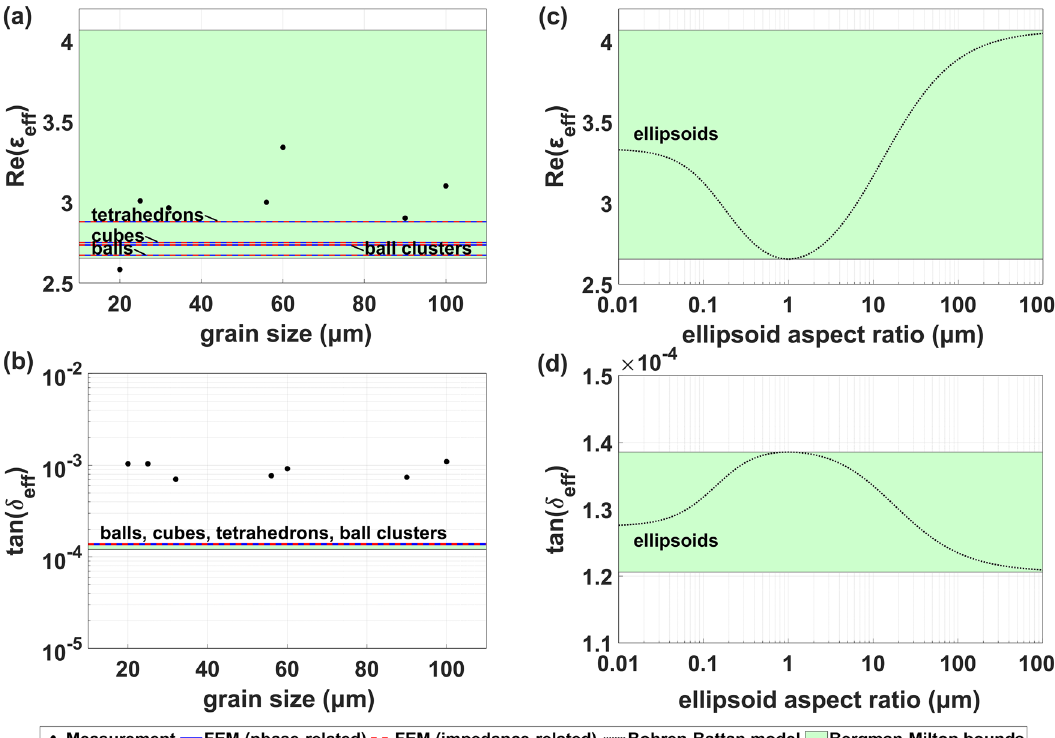
Figure 3. Impact of the grain size, shape, and clustering on ( a , c ) real part, and ( b , d ) loss tangent of the composite dielectric constant with wt = 29.6% at the frequency of 5 GHz. Results for non-ellipsoidal ( a , b ) and ellipsoidal ( c , d ) inclusion shapes are presented. Theoretical Bergman-Milton bounds are presented for